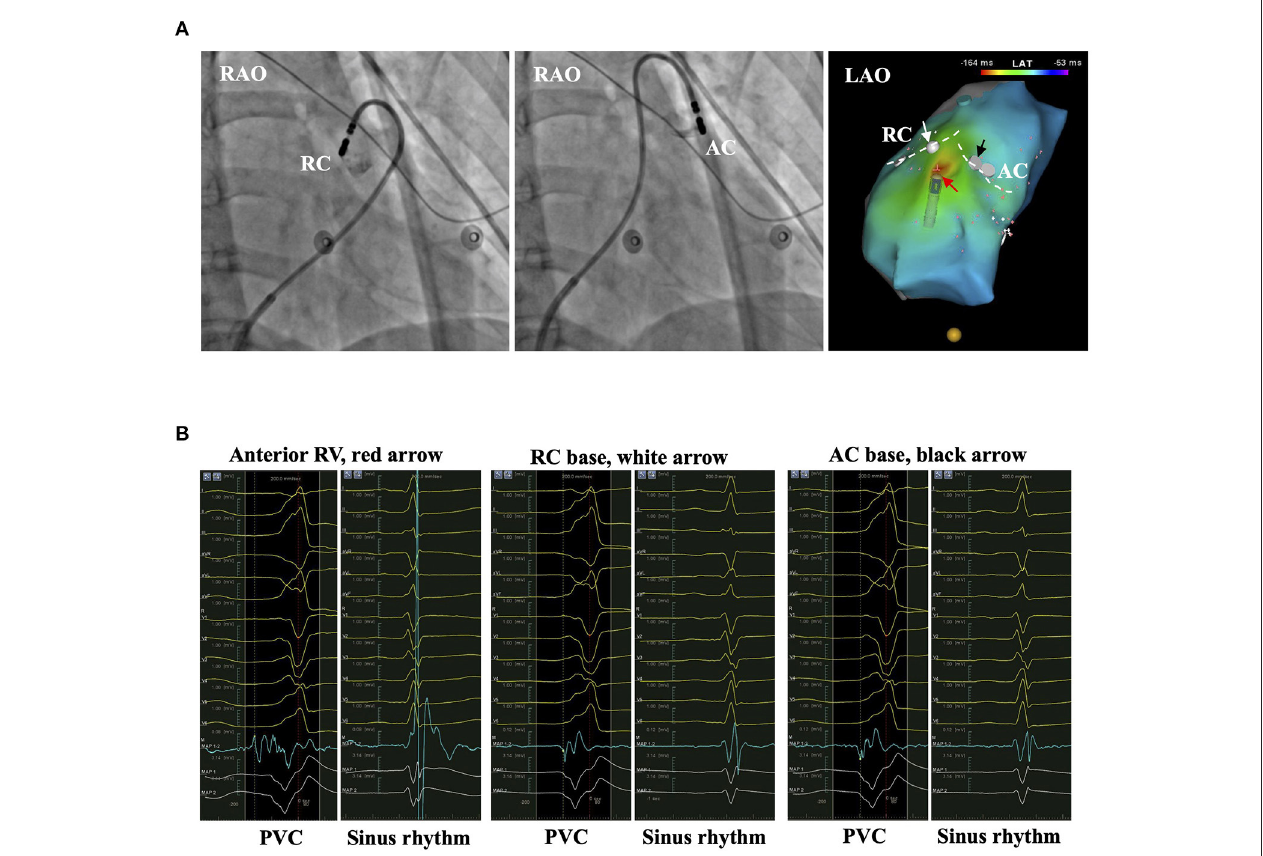
FIGURE 7 | The representative patient with PVC originating from anterior RV. (A) The left and middle panels show the bases of RC and AC by injecting contrast from the irrigation tube of the catheter. The right panel shows the activation mapping. The white dashed line denotes the PVVJ. The red arrow marks the EVA site 8.5mm beneath PVVJ. White and black arrows mark the less early activation site at the base of RC and AC. (B) The panels show the electrograms in PVC and sinus rhythm recorded at the arrow-denoted sites from left to right. The red dashed line denotes the time point of reference. The yellow dashed line denotes the LAT. AC, anterior cusp; EVA, earliest ventricular activating; LAT, local activating time; PVC, premature ventricular contraction; PVVJ, pulmonary valve–ventricle junction; RC, right cusp.